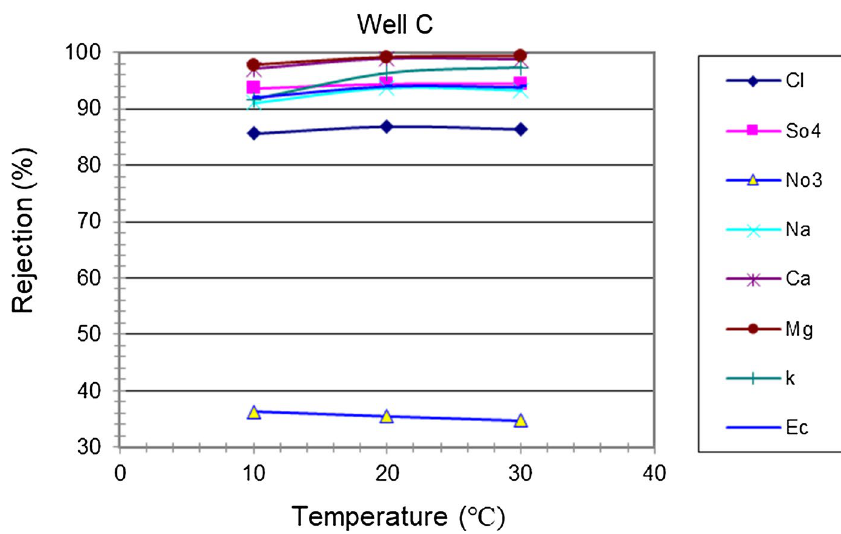
Fig. 13 Rejection rate of ions versus temperature (pressure: 12